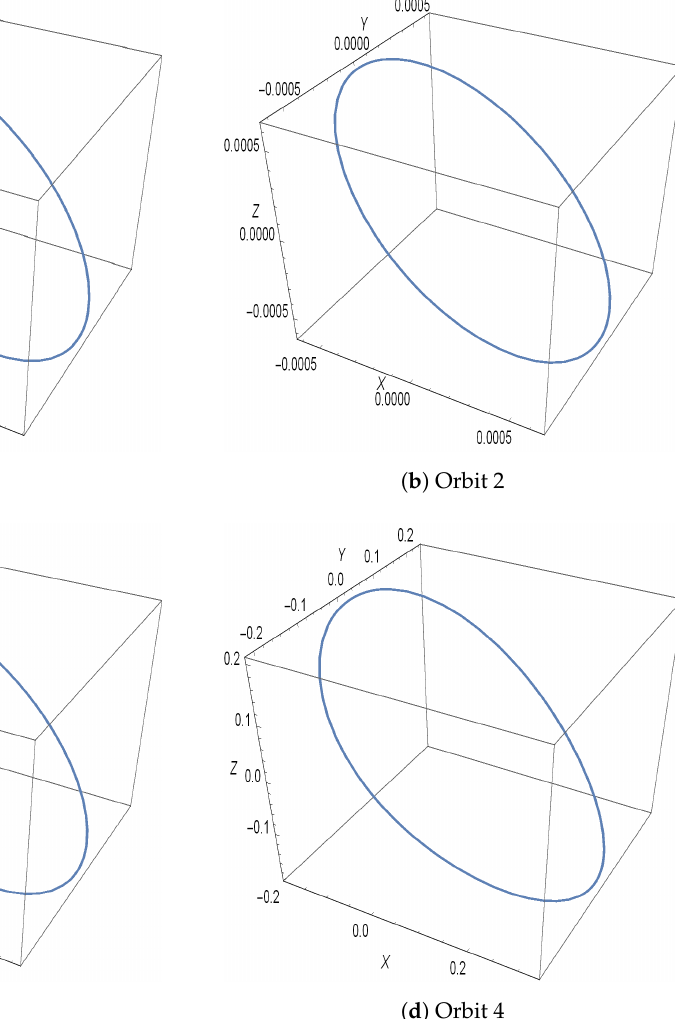
Figure 1. Pictures of Orbits 1 to 4.